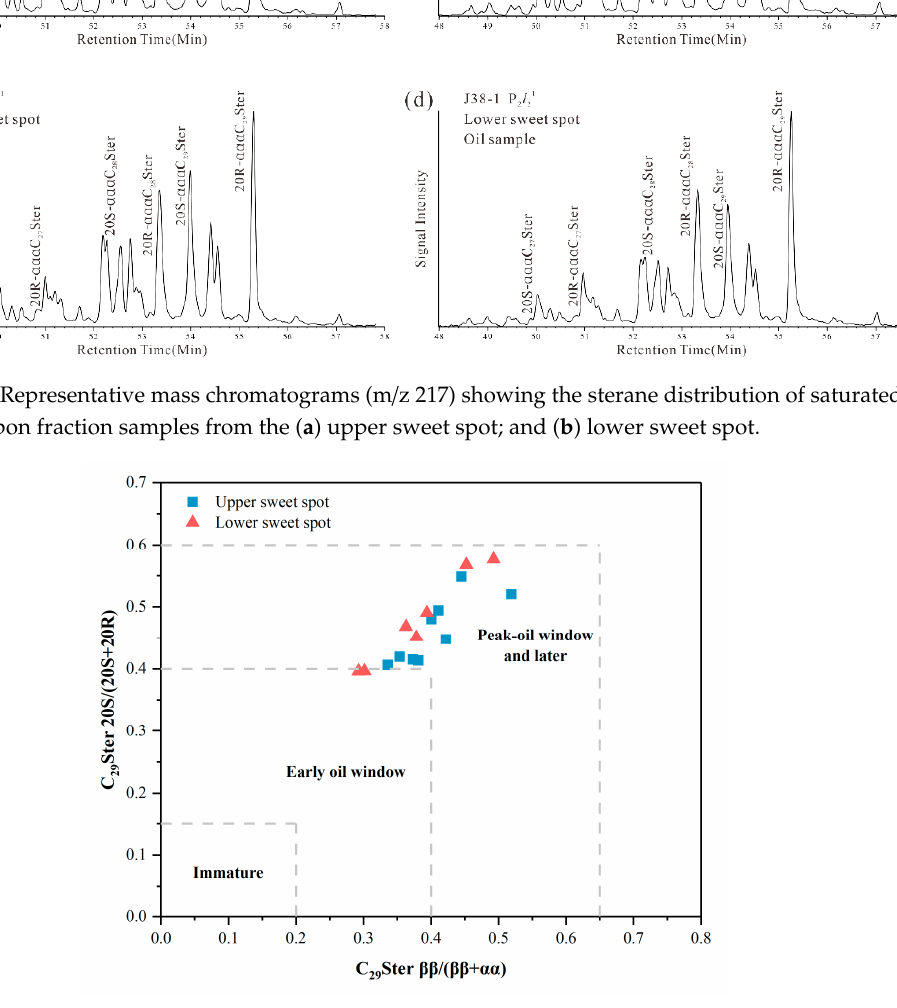
Figure 7. Plot of C 29 Ster 20S / (20S + 20R) vs. C 29 Ster ββ / ( ββ + αα ) showing the similar thermal maturity of upper and lower sweet spot oil samples.